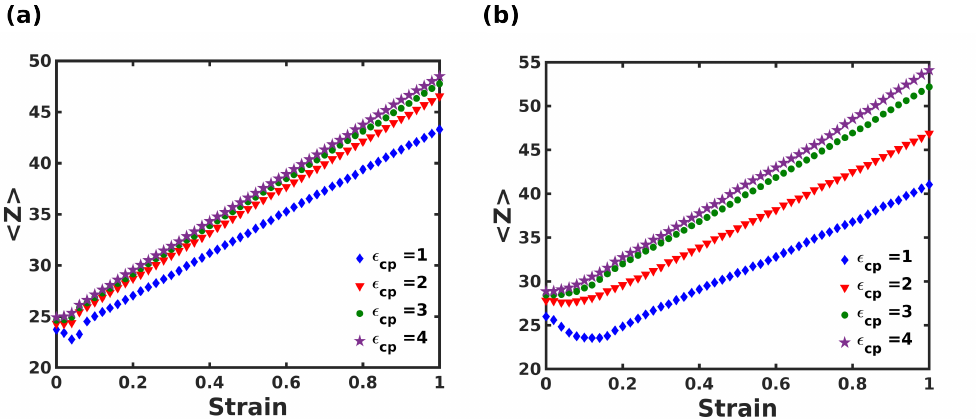
Figure 7. Plot of polymer-crystal coordination number at the interface as the function of strain for ( a ) columnar, ( b ) staggered composite for varying polymer-crystal